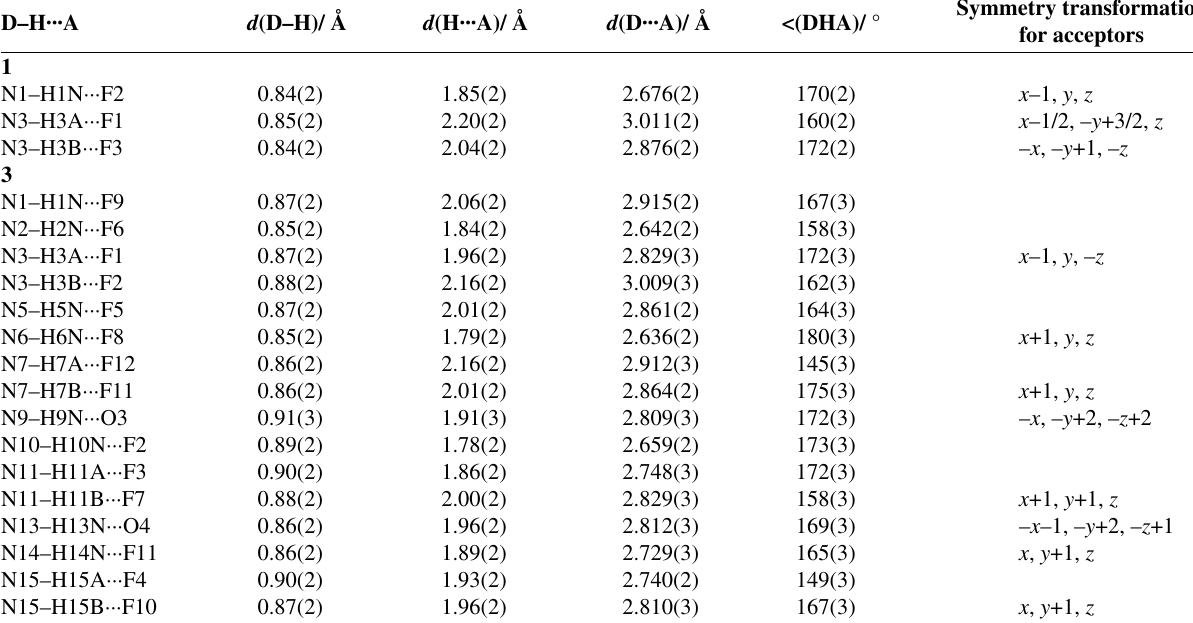
Table 3. Hydrogen-bonding geometry for 1 and 3 .